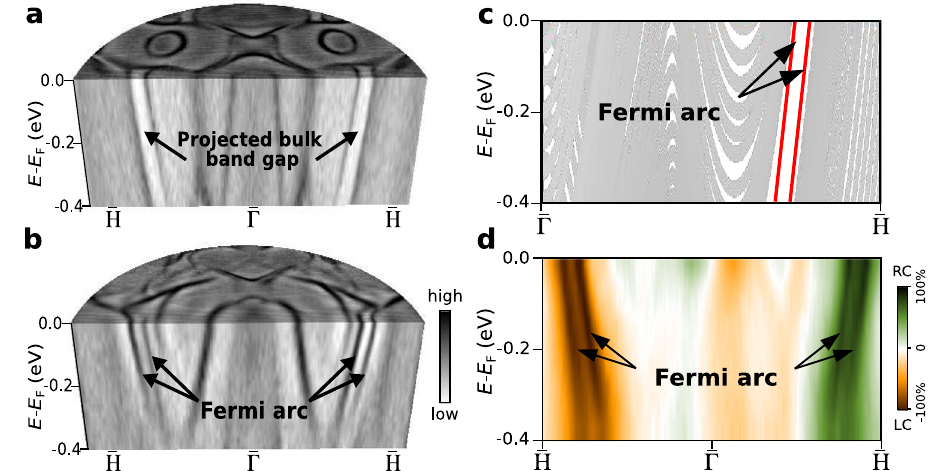
Fig. 2 | Fully helicity-selective surface arcs. Band dispersions measured on a W(110) and b 2 MLs Fe/W(110) along H (cid:3) Γ (cid:3) H at the photon energy h ν =50eV for the magnetization direction M + y . c Schematic diagram of the two co- propagatingsurfaceFermiarcs(redlines)inthe2Dtopologicalferromagnet,which appear inside the spin-orbit-induced projected band gap (large white area) of the